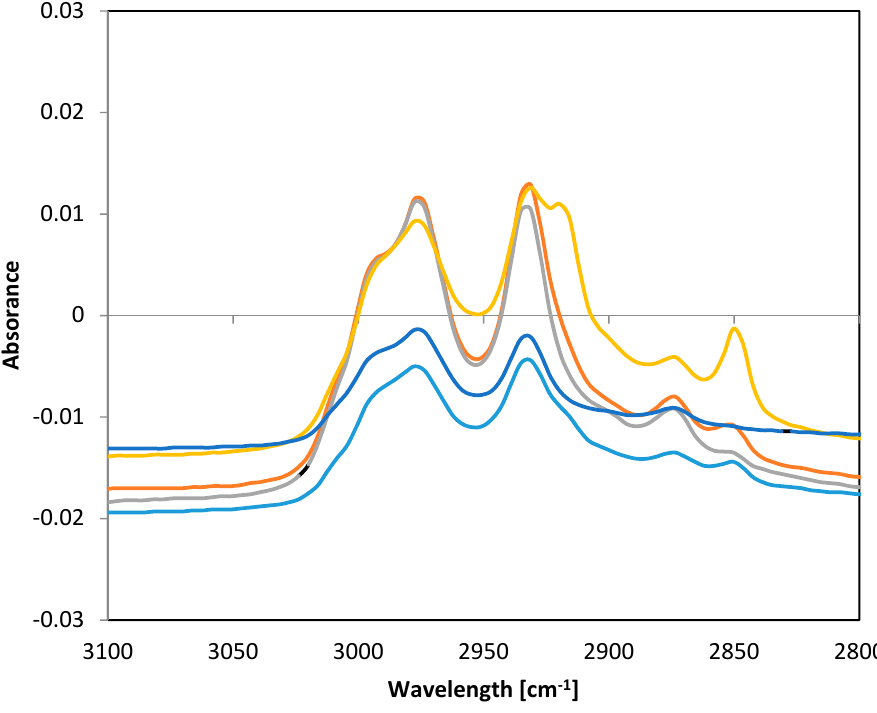
Figure 8. FTIR-ATR spectra of PHB fibers with incorporated plant oil extracts. Note: blue—pure PHB fibers, turquoise—PHB + oak bark, red—PHB + cinnamon, green—PHB + cloves,